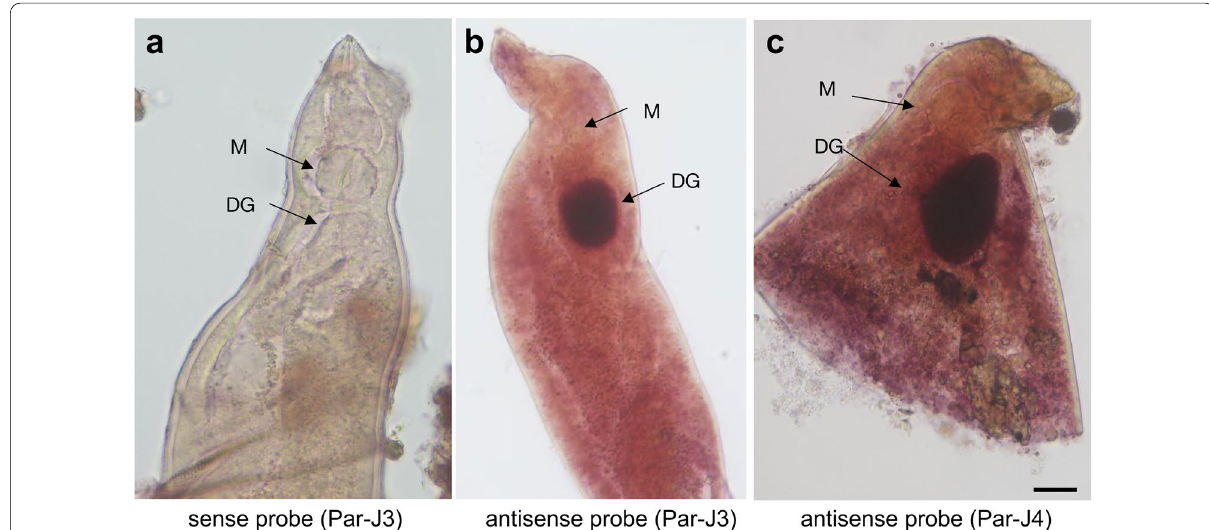
Fig. 1 SCN-27D09 is expressed in the dorsal gland of plant-parasitic nematodes. In situ hybridization was performed to detect tissue localization of SCN-27D09 transcript using digoxigenin-labeled sense ( a ) and antisense ( b , c ) cDNA probes of SCN-27D09 . Parasitic third- and fourth-stage juveniles of Heterodera glycines were used. M, metacorpus; DG, esophageal dorsal gland. Bar